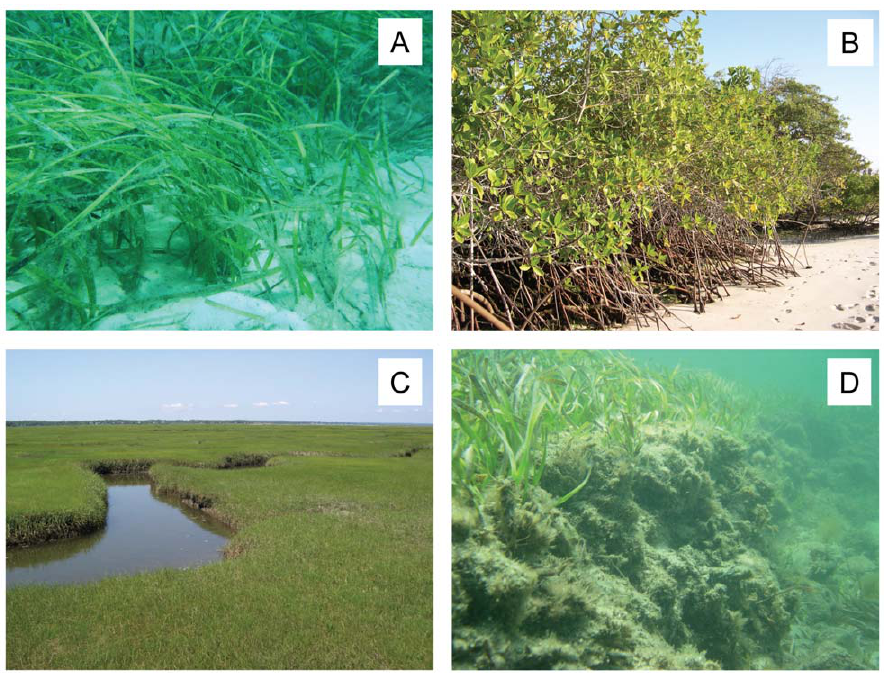
Figure 1. Major carbon-storing habitats on tropical and temperate coasts. Degradation and loss of (A) seagrass meadows, (B) mangrove forests, and (C) salt marshes may release hundreds to thousands of years worth of stored carbon through exposure and breakdown of below-ground biomass, shown in (D) for seagrasses. Photo credits: Andrew Irving.